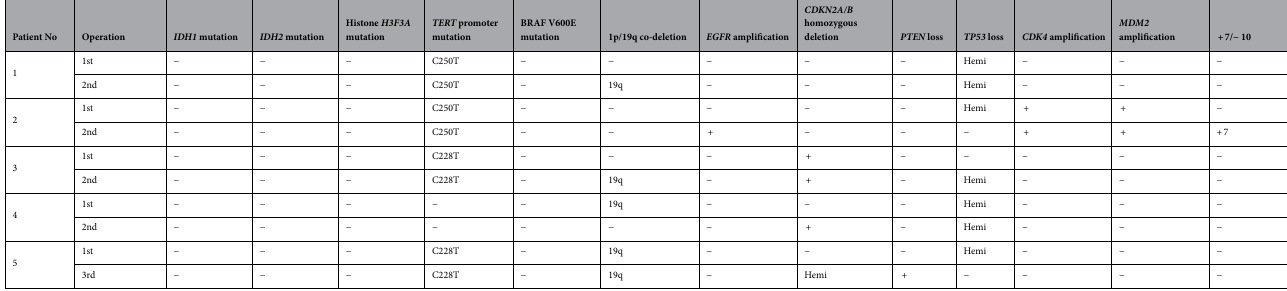
Table 2. Molecular alterations observed in five patients with initial and recurrent localized IDH wild-type histologically diffuse astrocytomas. IDH isocitrate dehydrogenase, TERT telomerase reverse transcriptase,